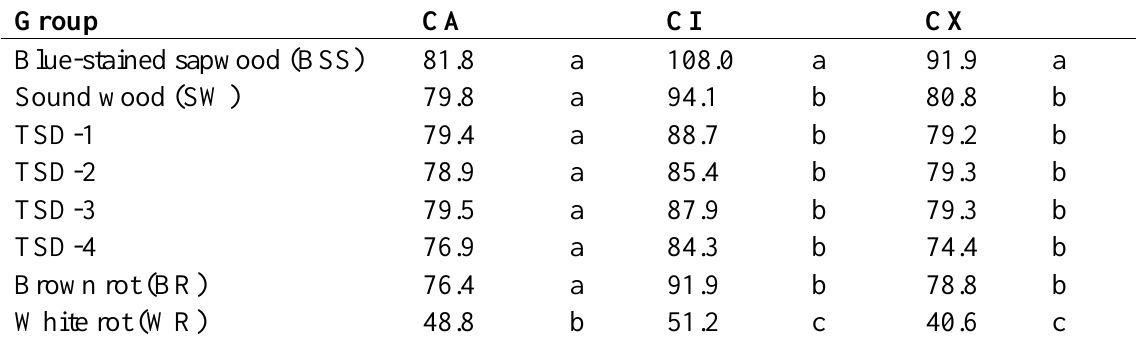
Table 1. Statistical grouping of means of three wood-cement compatibility indices. Means with the same letter are not significant different at the 95 percent